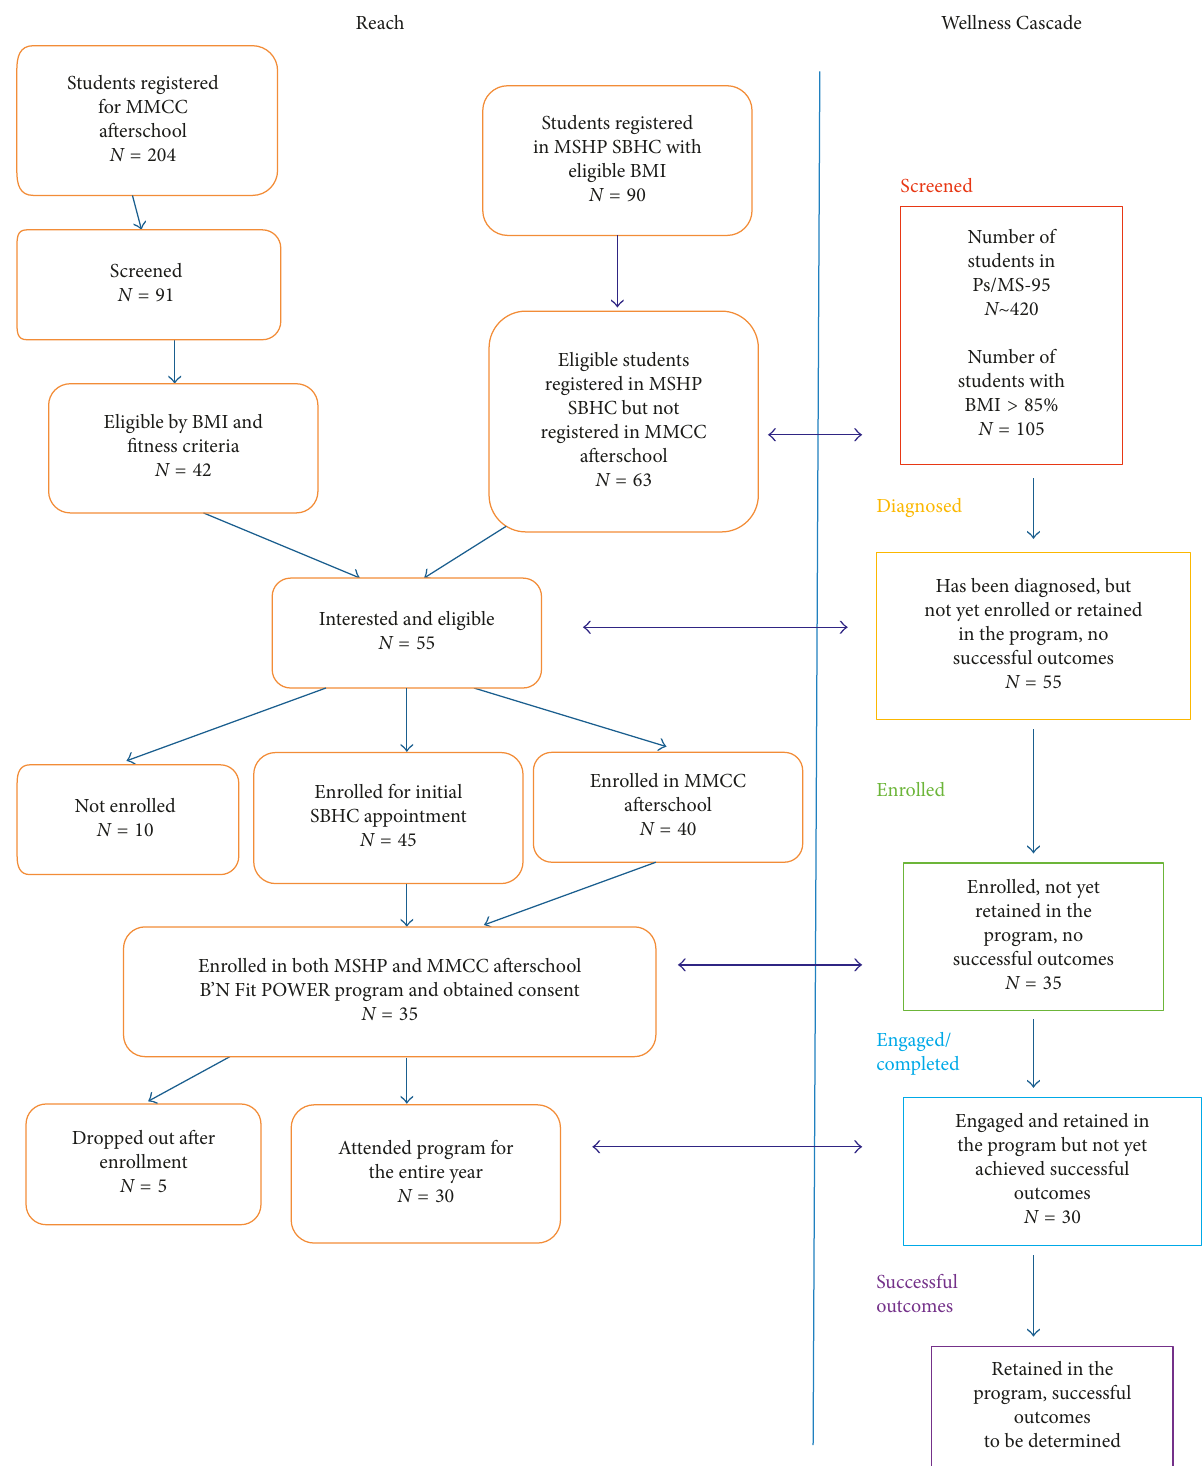
Figure 2: Implementation evaluation based on RE-AIM and Wellness